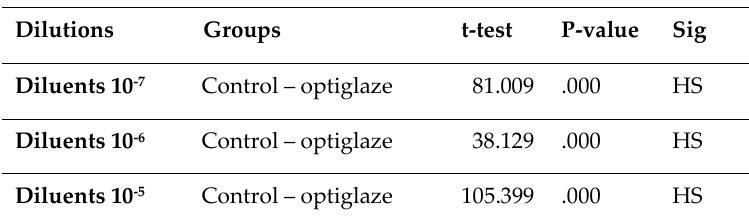
Table 6 : t-test between control and optiglaze group for viability test